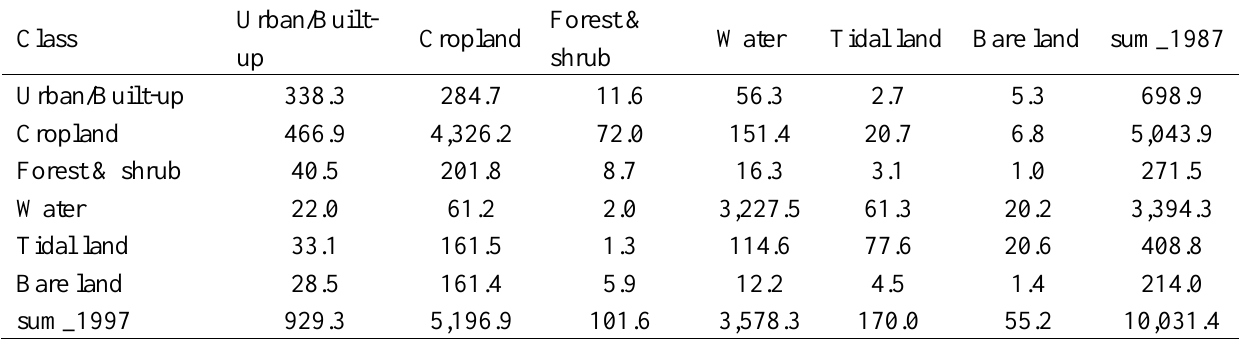
Table 6. Land use transformation matrix in 1987–1997 (unit: km 2